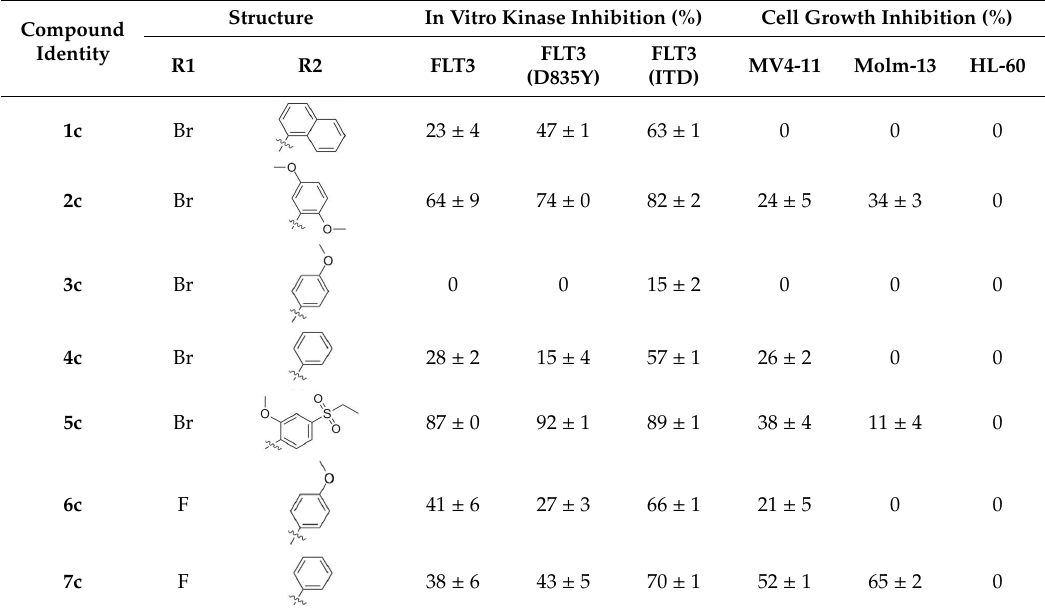
Table 1. Inhibitory activities of 11 synthesized compounds (100 nM concentration) on FMS-like tyrosine 3 (FLT3) kinases and cell growth. Compound Identity